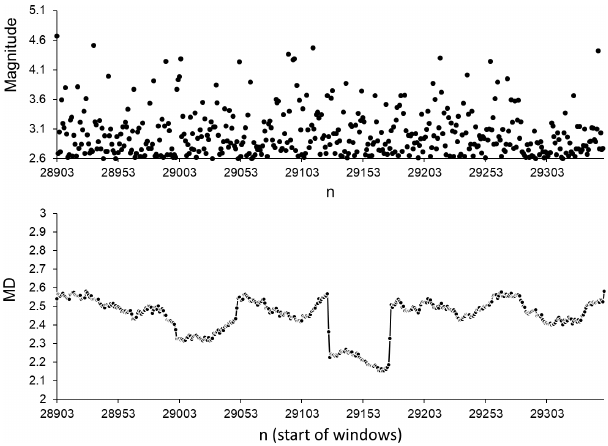
Figure 12. Magnitudes and MD values calculated for part of the SC catalogue after M 7 . 2 (4 April 2010, sequential number in SC cata- logue 28129) from 6 April 2010 (sequential number in SC catalogue 28903) to 8 April 2010 (sequential number in SC catalogue 29350). Average MD values were calculated for 50-data windows shifted by one data step; 99% of the earthquakes in this period occurred within a distance of 0.7–60km from the epicentre of M 7 .